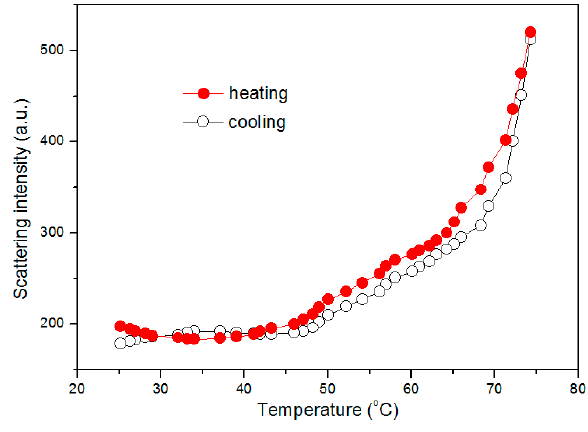
Figure 8. Temperature dependence of I 390 for 1.62 g·L − 1 mPEG-maleic rosin solution during one heating and cooling cycle.